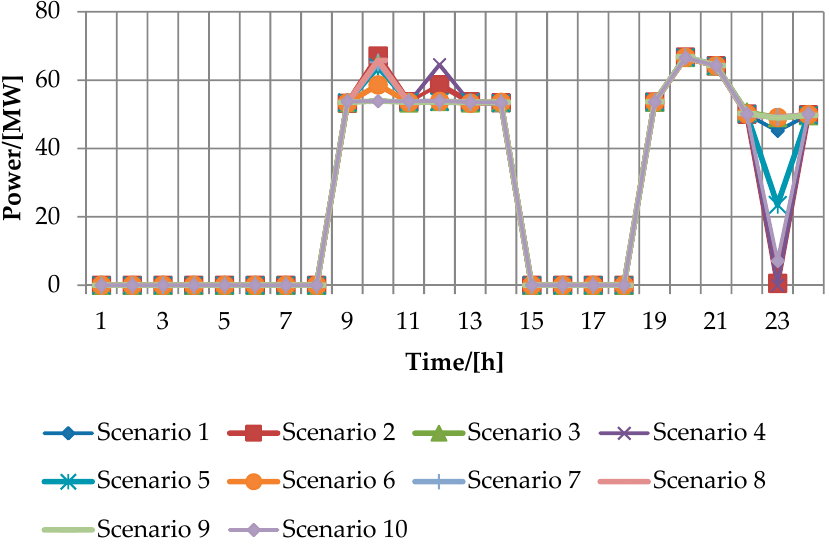
Figure 9. Load reduction curves under different scenarios (25%).